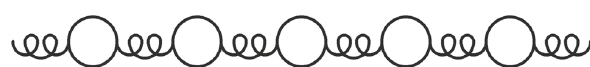
Fig. 1 Example of bubble-chain of length 5